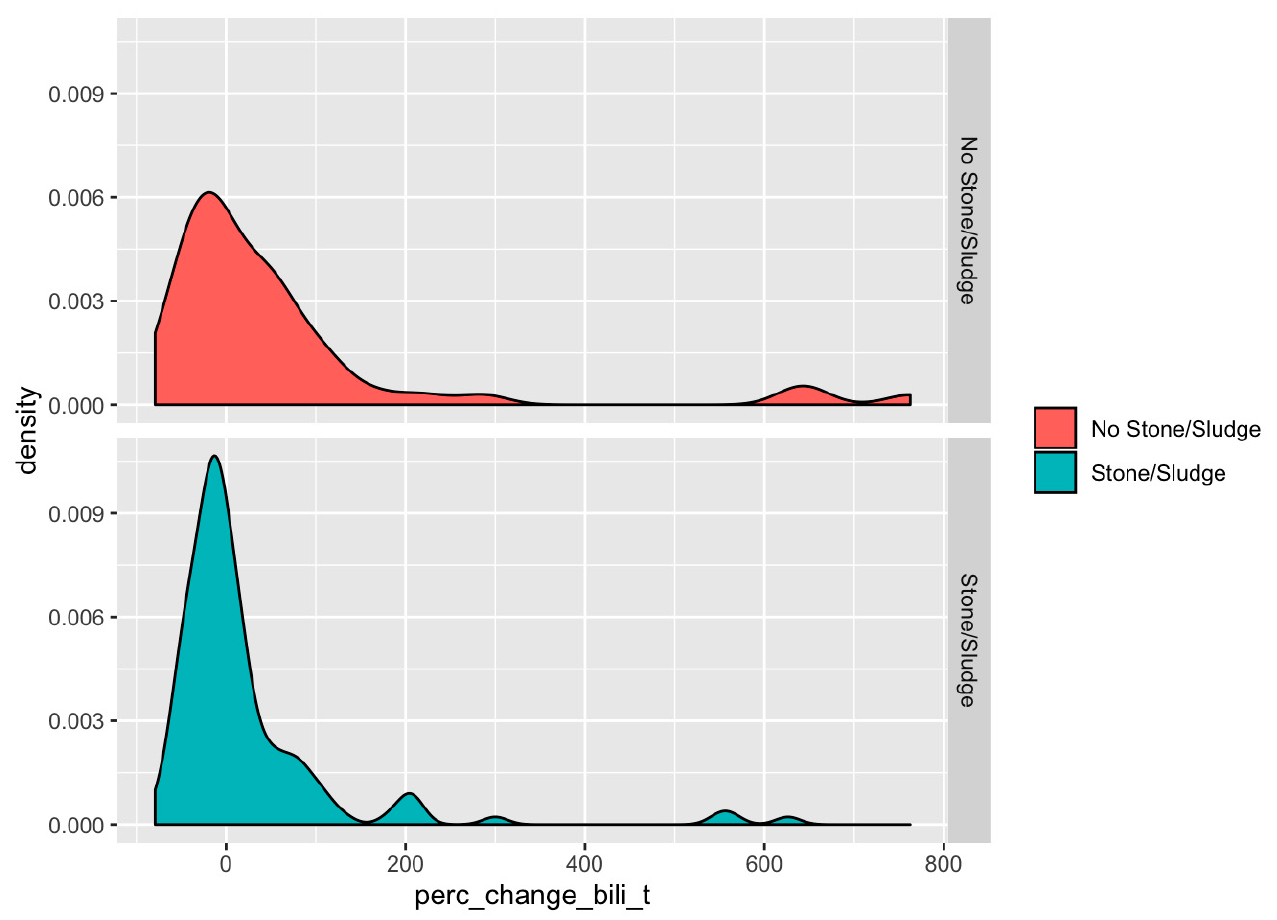
Figure 2. Density plots of percent change in total bilirubin for patients with and without an eventual finding of choledocholithiasis. Table 5. Performance characteristics of endoscopy-society choledocholithiasis guidelines when applied to the study